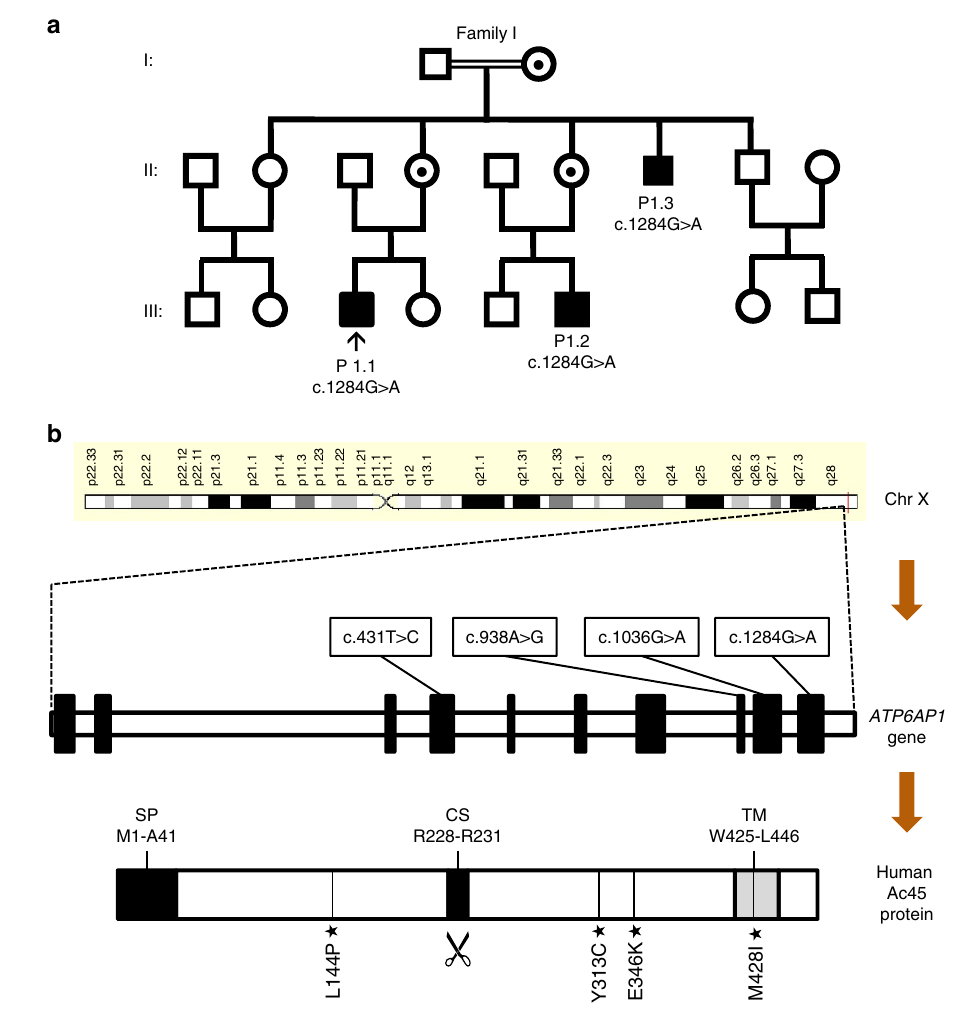
Figure 1 | Overview of identified ATP6AP1 mutations. ( a ) Pedigree of index family 1. Black arrow ( m ) indicates the index patient P1.1 with the mutation c.1284G 4 A (p.Met428Ile). ( b ) ATP6AP1 g ene, located on chromosome Xq28, and its gene structure consisting of 10 exons. All mutations identified in the six families are indicated in boxes. Domain structure of Ac45 as published on uniprot.org for human Ac45 (http://www.uniprot.org/uniprot/Q15904; Entry version 146, 07 January 2015). CS, furin proteolytic cleavage site 30 ; SP, signal peptide; TM, transmembrane region. Stars ( % ) indicate the location of the mutations at the protein level. See also Supplementary Fig.